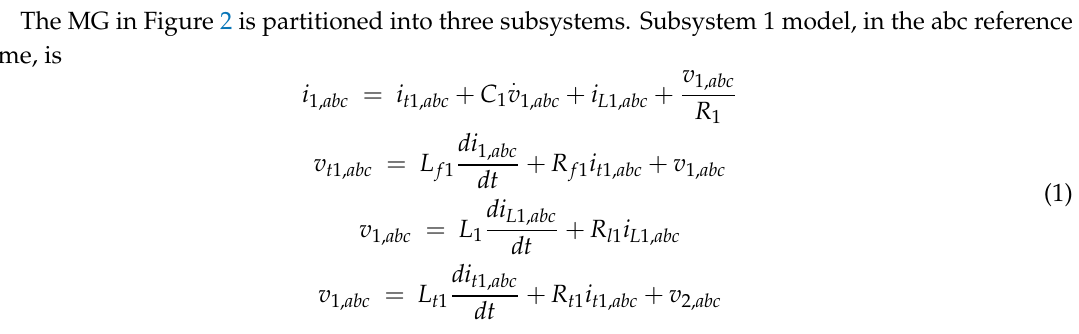
Figure 2. Single-line diagram of the microgrid.